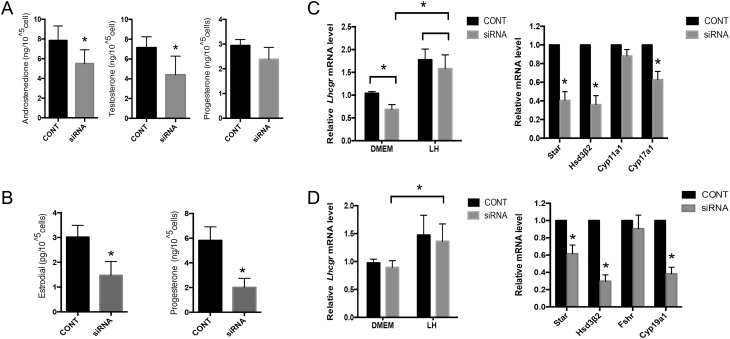
Bmal1 downregulation decreased luteal hormones synthesis and impaired mRNA transcriptions of steroidogenesis-associated genes in lutenized follicle cells. (A) Androgen and progesterone concentrations in TCs’ supernatants. (B) Progesterone and estradiol levels in GCs’ supernatants. Bmal1 interference deteriorated P4 and E2 production. (C) Left, TCs’ Lhcgr mRNA levels. Right, mRNA transcriptions of other targeted steroidogenesis-associated genes in TCs. (D) Left, GCs’ Lhcgr mRNA levels. Right, mRNA transcriptions of other targeted steroidogenesis-associated genes in GCs. The relative mRNA expression was normalized to Gapdh and expressed as relative to CONT. siRNA, group of cells transfected with siRNA against Bmal1. CONT, cells transfected with siRNA with empty vector as controls. LH, cell cultured with LH supply additionally for 12 h. DMEM, cells cultured with regular culture media containing DMEM. mRNA levels of target genes in cells were quantified by qRT-PCR using their specific primers. Data are presented mean ± s.d. of five independent determinations. *P < 0.05 or less vs the control group.